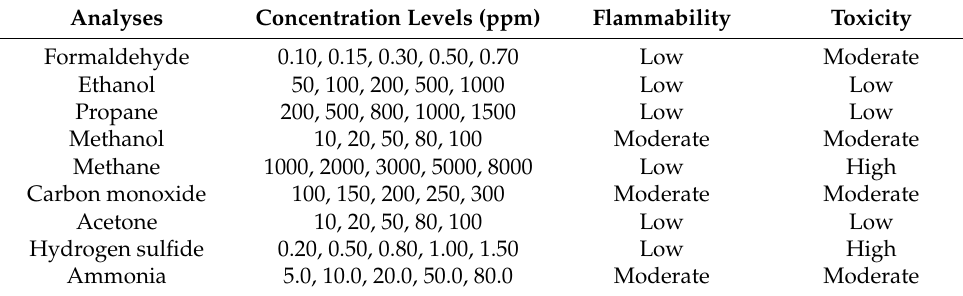
Table 1. Analyses and their concentration used in this work.